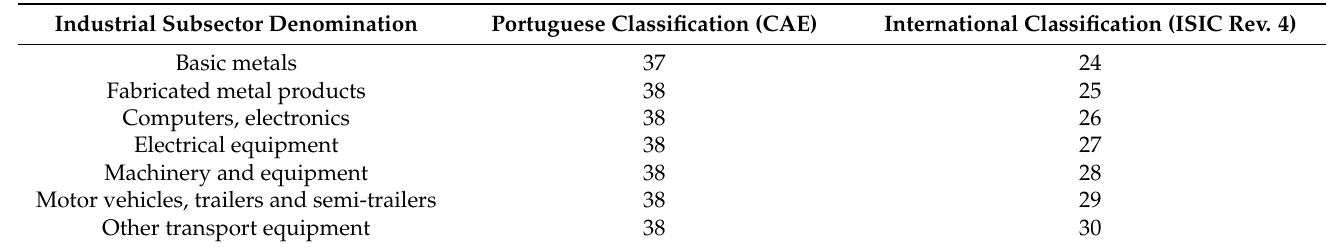
Table 1. Main industrial subsectors, directly or indirectly involved in the production of energy convert- ing machines, considered for the calculation of the energy intensity of the machinery sector